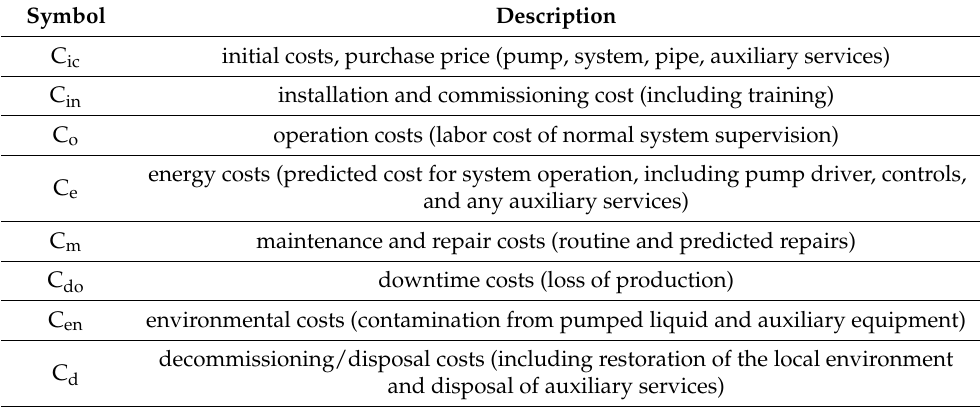
Table 4. Important parameters in calculating the (Life-Cycle-Cost) LCC.